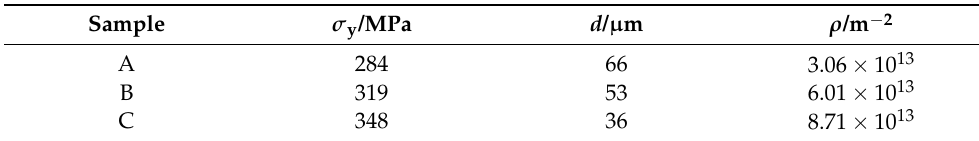
Table 9. Parameters used to derive the modified Hall-Petch parameter, K G , work hardening parame- ter, α ε , and intrinsic strength, σ 0